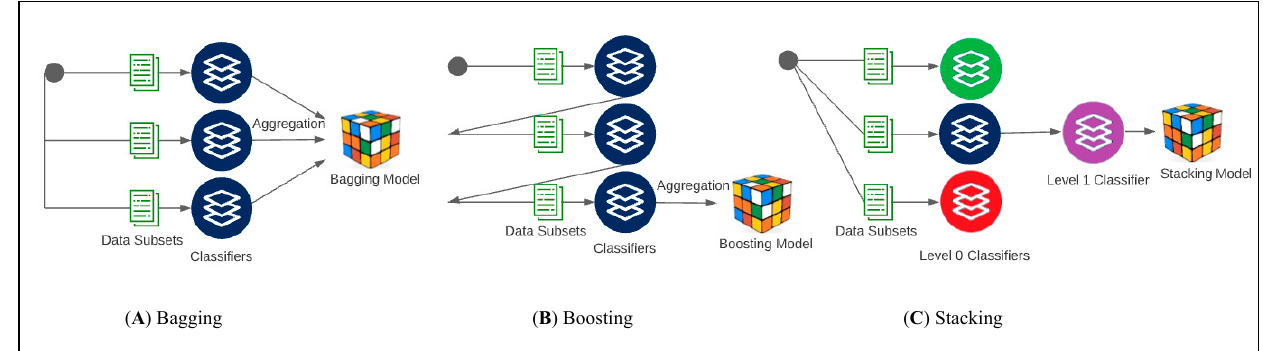
Figure 1. Ensemble techniques: Bagging, Boosting, and Stacking workflow.